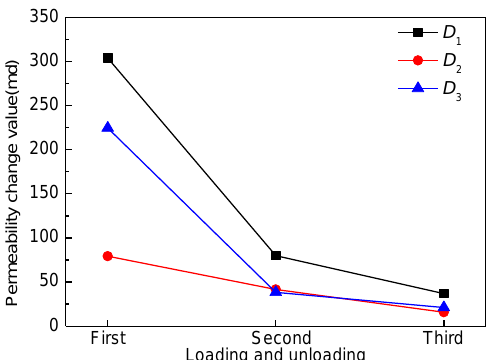
Figure 8. Relationship curve between D 1 , D 2 and D 3 values of coal samples and cyclic loading and unloading times.